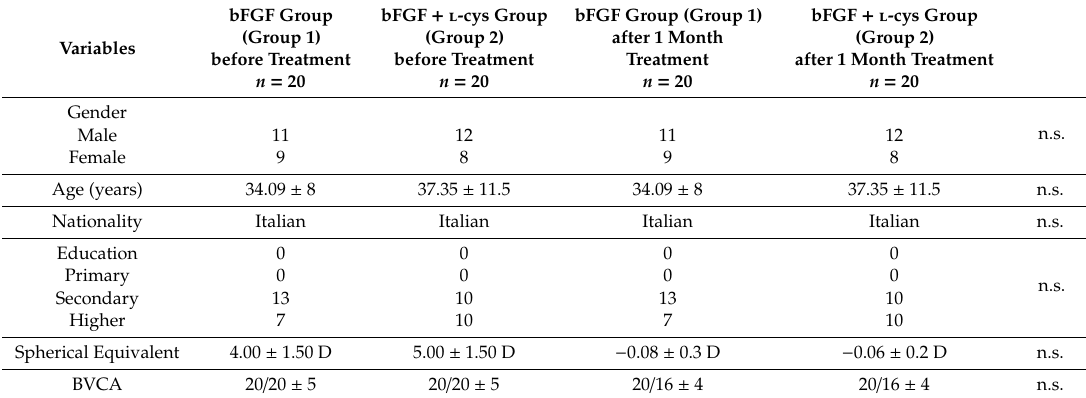
Table 1. A descriptive table of variables by groups. p > 0.05 (n.s.) Group 2 vs. Group 1 before and after